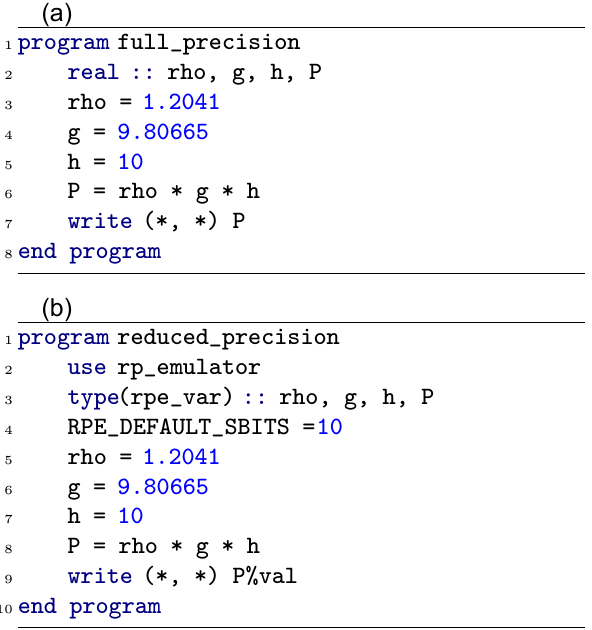
Figure 1. A simple numerical program using (a) standard single- precision arithmetic and (b) reduced-precision arithmetic with 10 significand bits.